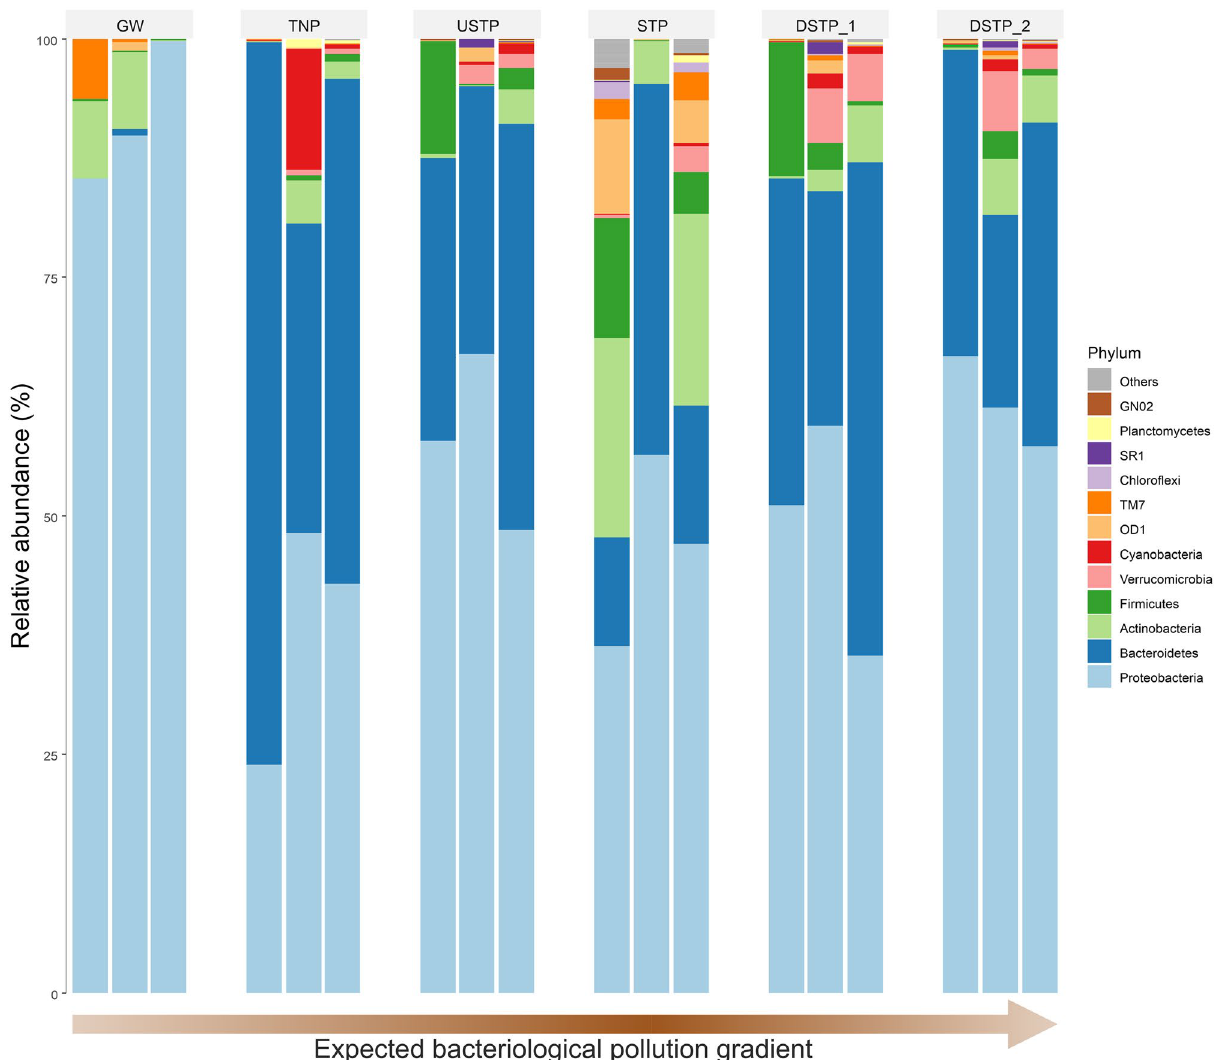
Figure 4. Changes in the relative abundance of bacteria at the phylum level along the pollution gradient of the Białka river. Three sampling seasons, i.e. summer, winter, and spring are shown from left to right. Arrow graph shows the expected bacterial pollution gradient, darker brown shade indicates the more contaminated sites, the arrowhead indicates the course of Białka river. Site abbreviations are as follows: GW—groundwater; TNP—Tatra National Park; USTP—upstream of the sewage treatment plant; STP—sewage treatment plant; DSTP1—c.a. 3 km downstream of the STP; DSTP2—c.a. 7 km downstream of the STP (for detailed description, please see caption of Fig.